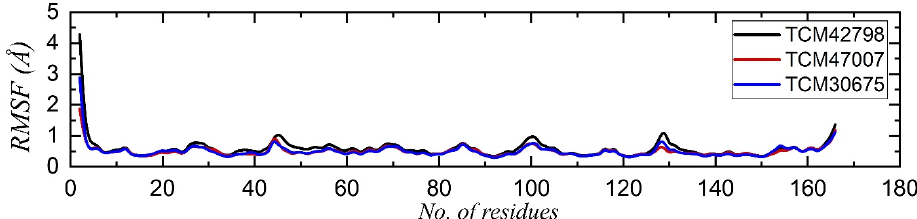
Figure 7. Residual flexibility analysis of the TCM42798, TCM47007, and TCM30675 complexes.